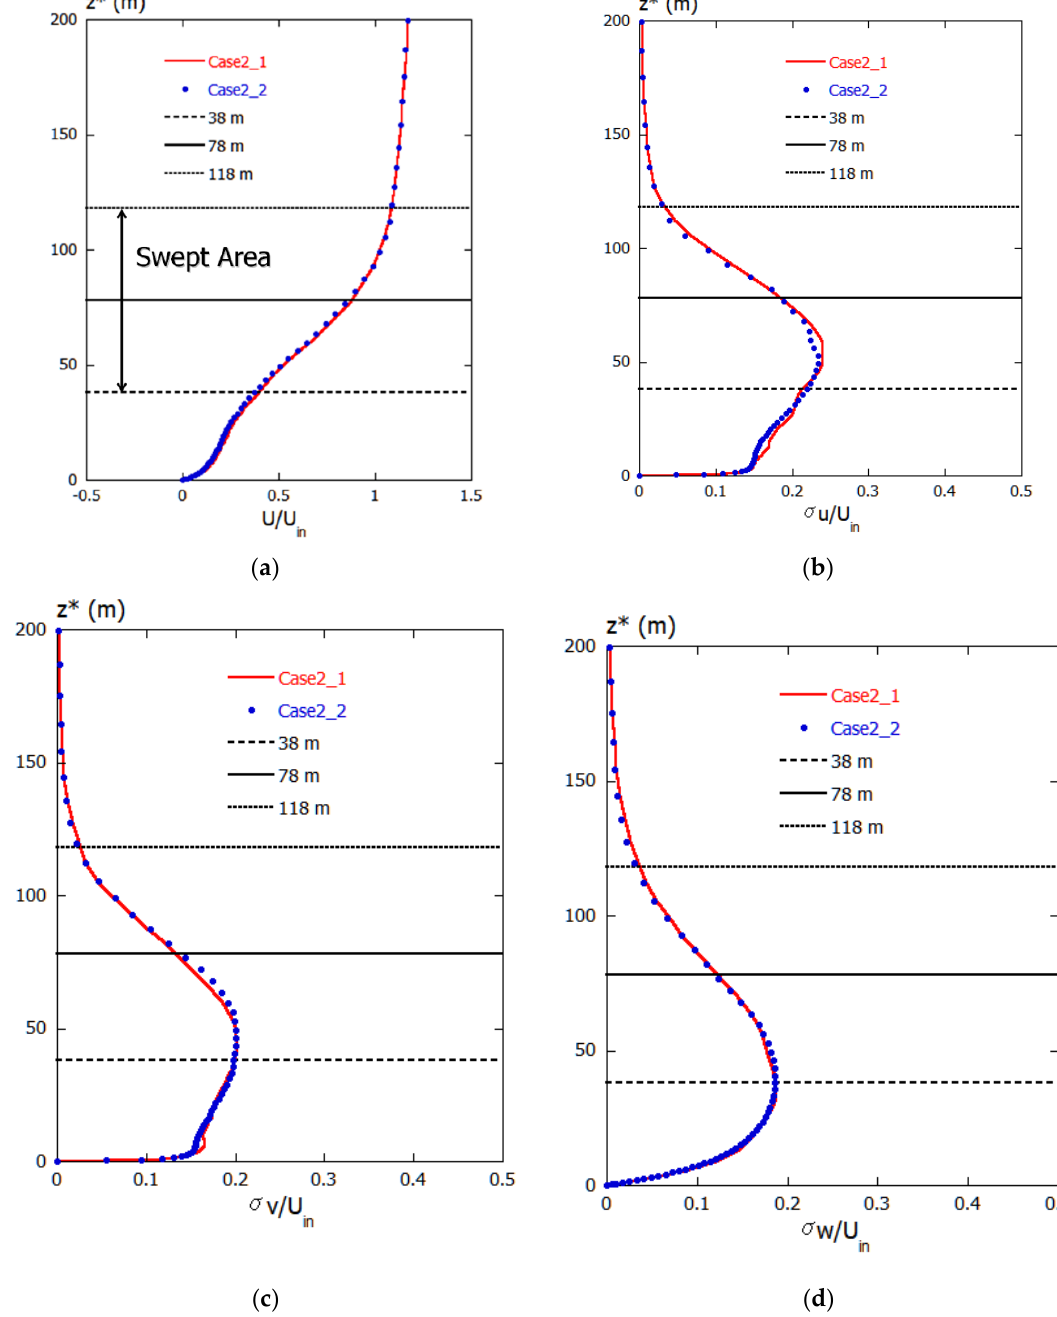
Figure 16. Comparison of vertical profiles of statistical quantities for Case2_1 and Case2_2. ( a ) Normalized mean streamwise wind velocity, ( b ) normalized standard deviation in the streamwise direction, ( c ) normalized standard deviation in the spanwise direction, and ( d ) normalized standard deviation in the vertical direction.